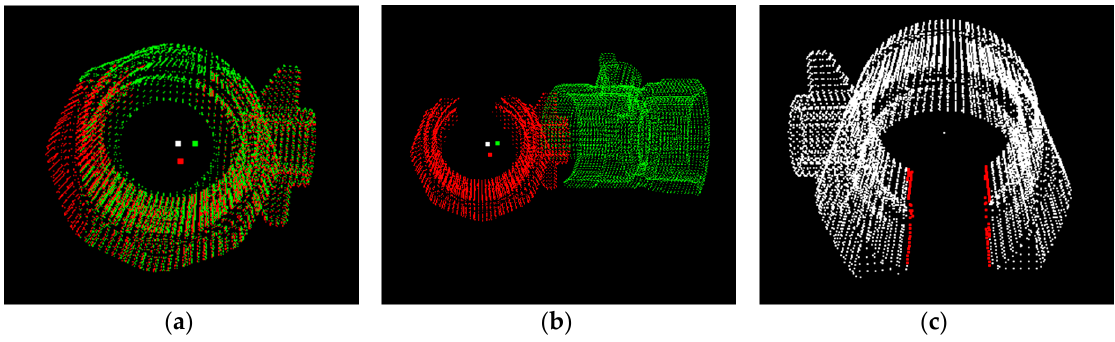
Figure 4. Improvement of translation: ( a ) The influence of weight loss from the missing points to the centroid point position; ( b ) Two point sets are separated; ( c ) Detection of the boundary points located near the missing part.